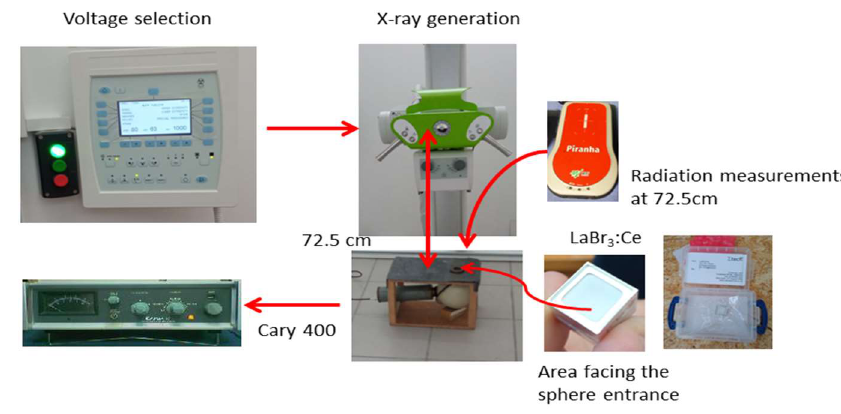
Figure 1. Experimental measurement